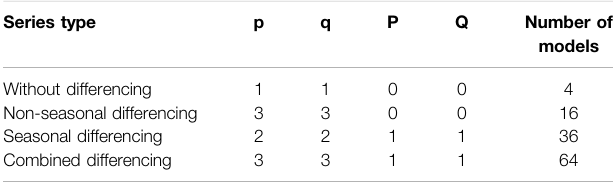
TABLE6| Ordersofparameterandnumberofmodelsrequiredfortheone-month drought index. Series type